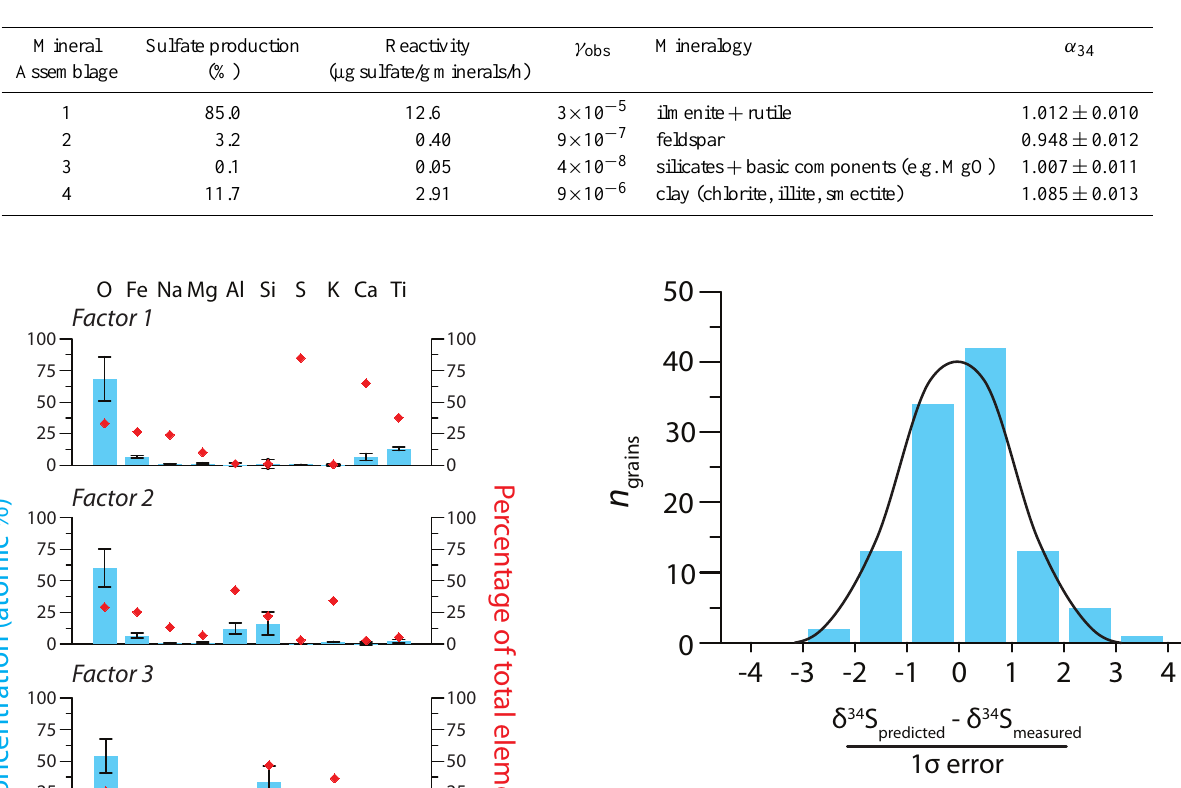
Table 4. Fractionation of 34 S/ 32 S during heterogeneous oxidation of SO 2 (g) on mineral dust surfaces. “Sulfate production” shows the percentage of the total sulfate production contributed by the mineral assemblage while “Reactivity” shows the amount of sulfate produced per gram of the minerals represented by the mineral assemblage per hour of reaction time at an SO 2 concentration of 4.2ppm for MDRHO3hv experiments. γ is the reactive uptake coefficient considering the BET surface area of the dust for MDRHO3hv experiments.